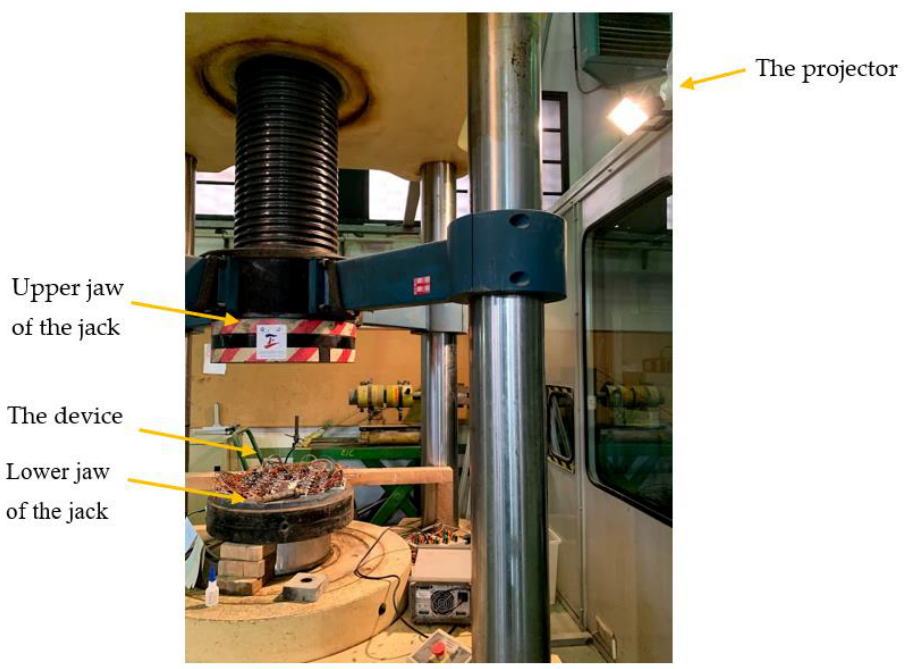
Figure 7. The laboratory experiment equipment.